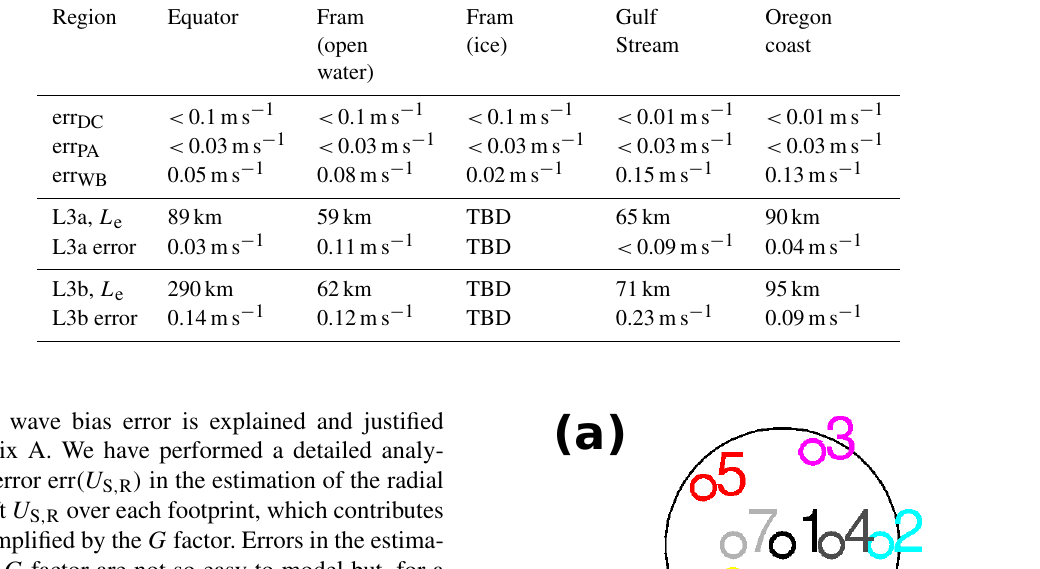
Table 1. Summary of expected RMSEs for Level 2 radial velocity (for θ i = 12 ◦ ) and along-track Level 3a (single swath snapshot) or zonal Level 3b (multi-swath time-evolving field) velocity component, based on the preliminary algorithms in the case of the SKIM2 configuration (open burst, eight beams). TBD stands for to be determined.